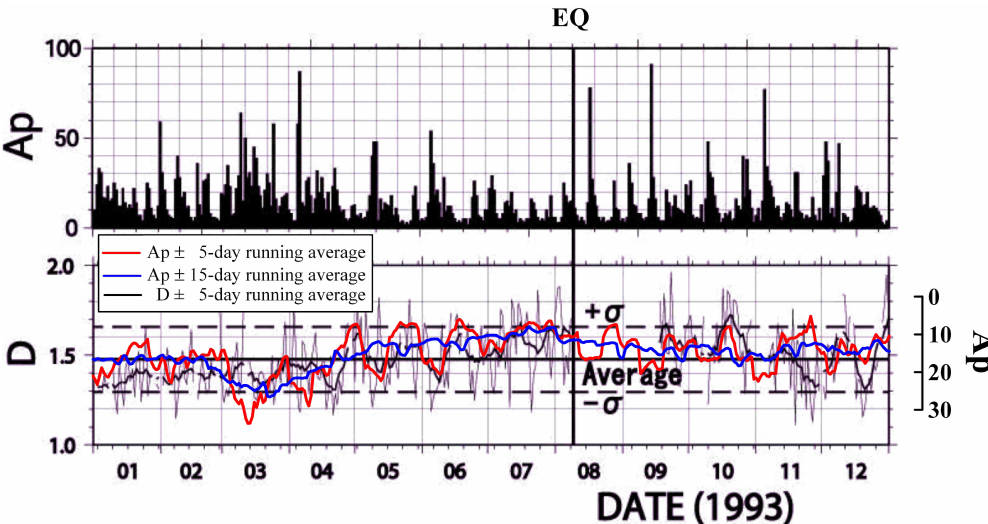
Fig. 3. Time-series of the fractal dimension D of the geomagnetic field H component at Guam observatory, and geomagnetic Ap index during 1993 as reported by Hayakawa (2011) (a reproduction of Hayakawa, 2011, Fig. 6). Ap ± 5-day and ± 15-day running averages are superimposed onto the original view. See text for